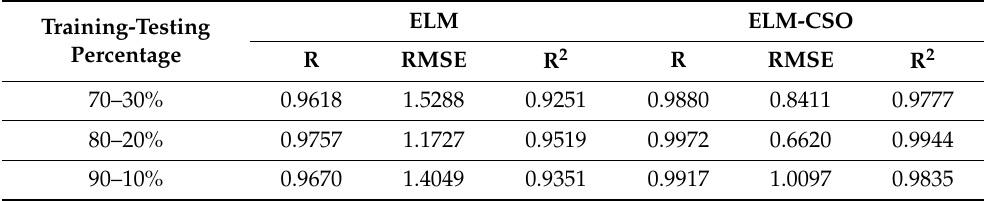
Table 6. Performance metrices comparison of ELM and ELM-CSO with missing